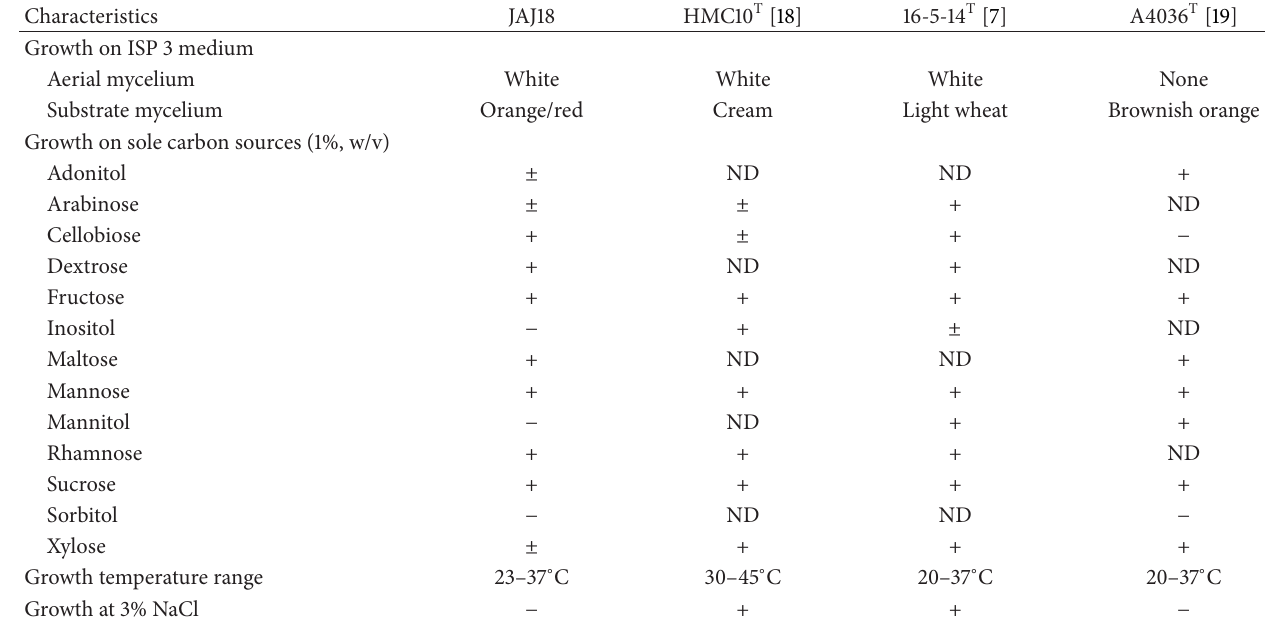
Table 4: Comparison of the phenotypic properties of Nonomuraea sp. JAJ18 with Nonomuraea maheshkhaliensis 16-5-14 T , Nonomuraea candida HMC10 T , and Nonomuraea jabiensis A4036 T .